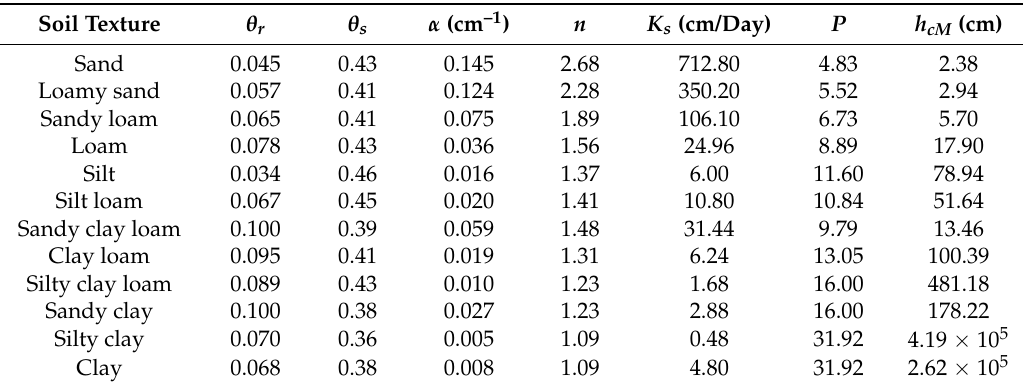
Table 1. Average van Genuchten model parameters for the 12 soil textural classes of the United States Department of Agriculture classification scheme [40] as well as parameters for Equations (2) and (3) calculated with Equations (31) and